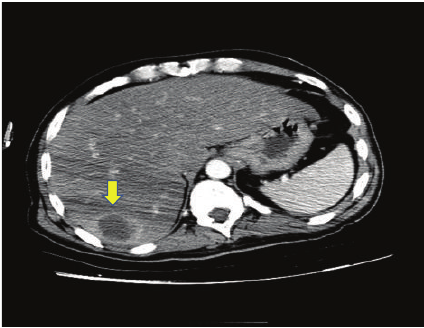
Figure 1: Computer tomography scan with contrast medium show- ing the liver mass with in the Segment VII of the right lobe with peripheral rim enhancement with central